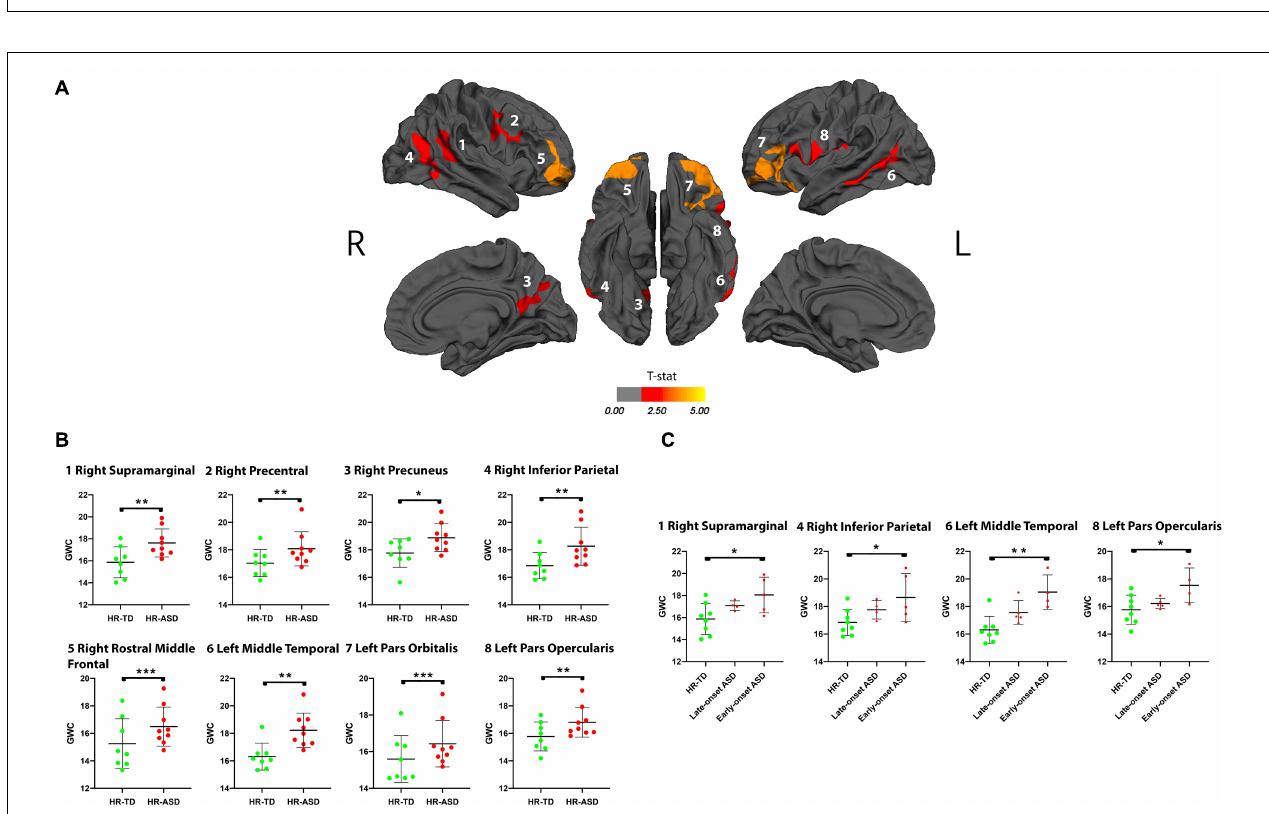
FIGURE 3 | (A) Clusters in which gray-white matter contrast (GWC) at age 12–24 months (computed as mean GWC between the two scan acquisitions) has a significant association with diagnostic outcome at age 3 (HR-TD or HR-ASD). Only clusters with CWP < 0.05 after regression for age are and correction for multiple comparisons are displayed. Within each hemisphere, clusters are numbered in order of decreasing effect size (Cohen’s D, see Table 2 ). Color code corresponds to p -value of the vertex with the greatest p -value within the cluster. P -values are represented as T-stat = -log( p -value). (B) Individual mean GWC values for each significant cluster are displayed. (C) Comparison between HR-TD and HR-ASD subgroups (LOA and EOA). Only clusters with a significant ANCOVA ( p < 0.05) are displayed. * p < 0.05, ** p < 0.01, and *** p < 0.001.